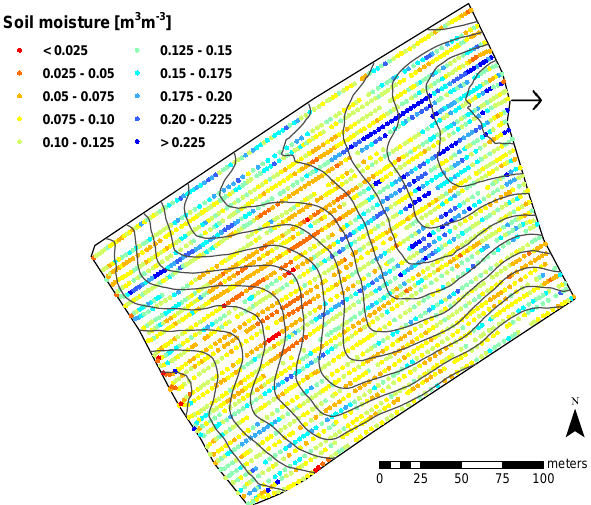
Fig. 1. Maps of soil moisture point-values retrieved by GPR inver- sions from the field acquisition in Marbaix, 15 April 2009. Contour lines with an interdistance of one meter are depicted in black lines. The outlet of the field is indicated by the black arrow. Projected coordinate system: Belgian Lambert 1972.